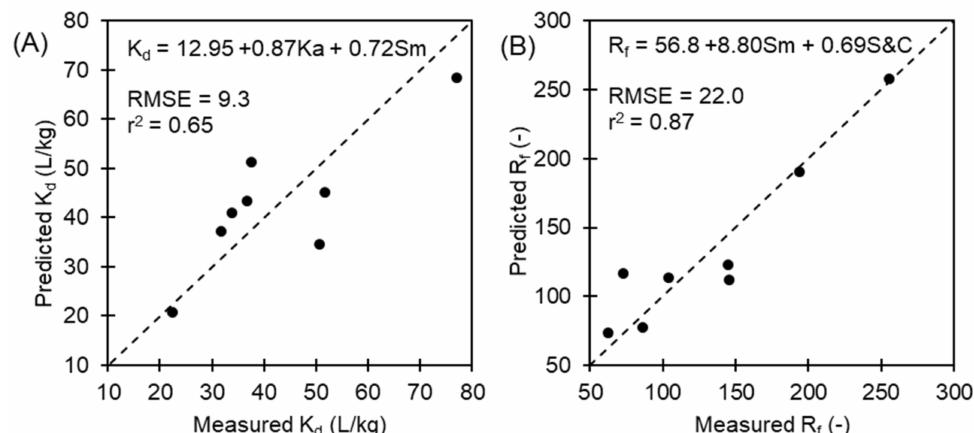
Figure 5. ( A ) Linear isotherm coefficient predicted using clay-fraction kaolinite (Ka) and smectite (Sm) weight percentages, and ( B ) retardation factor ( R f ) predicted using smectite and silt and clay fraction (S&C) (RMSE, root-mean-square